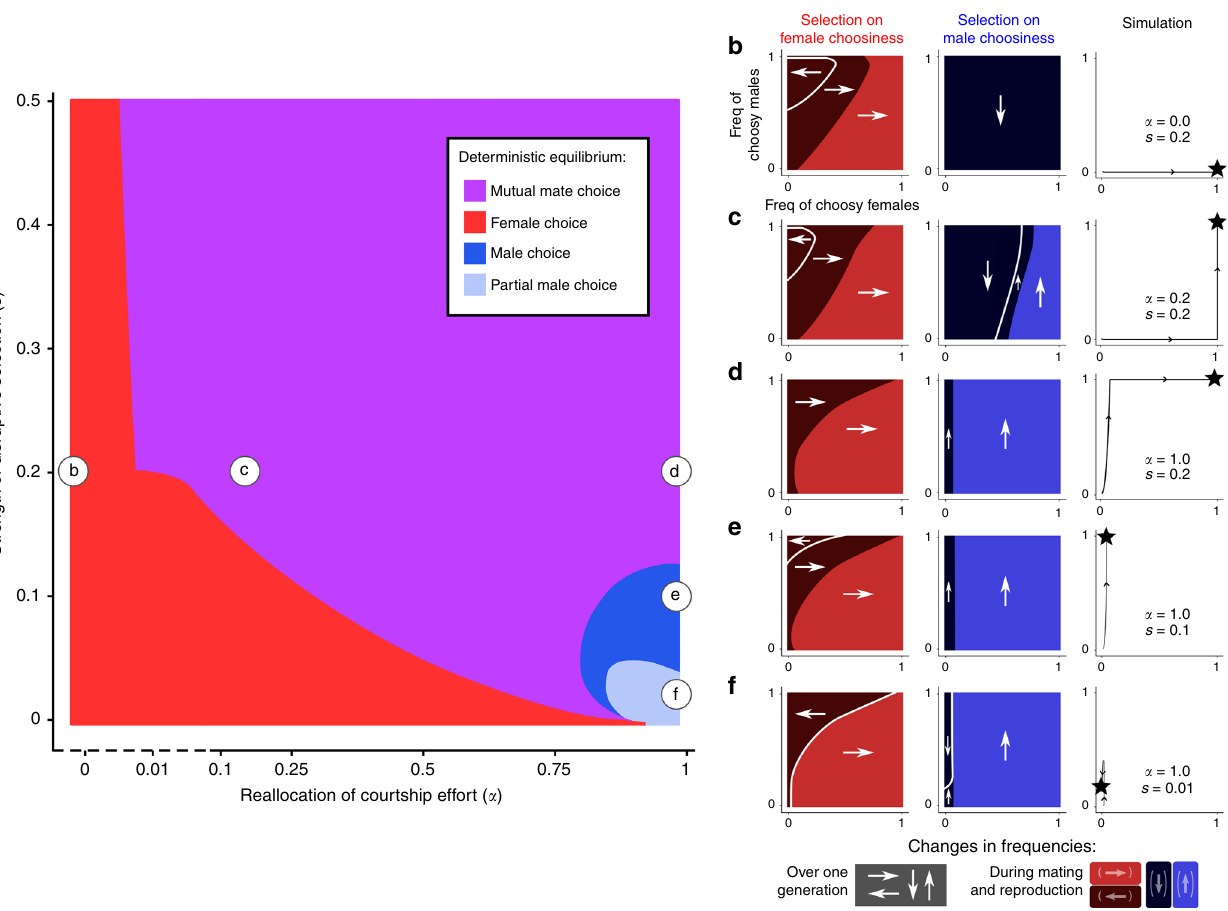
Fig. 2 Deterministic equilibrium for different combinations of courtship reallocation ð α Þ and strength of disruptive viability selection ð s Þ . Panels b – f refer to speci fi c combinations of ð α ; s Þ marked in panel a . In the rightmost plot of panels b – f , we draw the trajectory of individual simulations leading to deterministic equilibrium (represented by black stars, and color-coded in panel a ). We also measure the change in frequencies of choosy females and choosy males due to the combined action of all selective forces over one entire generation (white arrows). Indirect viability selection always increases the frequencies of choosy individuals (not shown). The change in frequencies of choosy females and choosy males during mating and reproduction (i.e., excluding the viability selection part of the life cycle) is represented by dark and light colors (dark: decrease in frequency, light: increase in frequency, as illustrated by the arrows in brackets in the legend). The colors in panels b – f thus capture the (direct and indirect) consequences of sexual selection. Depending on ð α ; s Þ , female mate choice, male mate choice, or mutual mate choice can be the stable deterministic equilibrium ( a ). In particular, under strong disruptive viability selection ( s (cid:2) 0 : 2), mutual mate choice evolves even if choosy males reallocate little courtship effort toward preferred females ( α (cid:2) 0 : 01, note the logarithmic scale in the left part of the x-axis in panel a ). In that case, the evolution of female choosiness favors the evolution of male choosiness by increasing the mating success of choosy males (leading to an increase in the frequency of choosy males during mating and reproduction in Female and male populations are rarely simultaneously partly choosy (regime P ) for both low and high values of α (Fig. 3b). When α < 0 : 01, male choosiness does not evolve and female choosiness is under suf fi ciently strong selection to remain at high frequency (regime F ). When α > 0 : 9, choosy males can reallocate most of their courtship effort, and male female choosiness (and the associated sexual selection) is